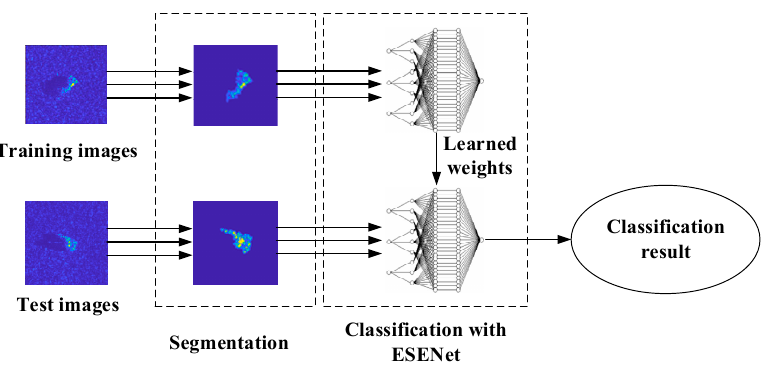
Figure 3. Overview of the proposed SAR ATR method.